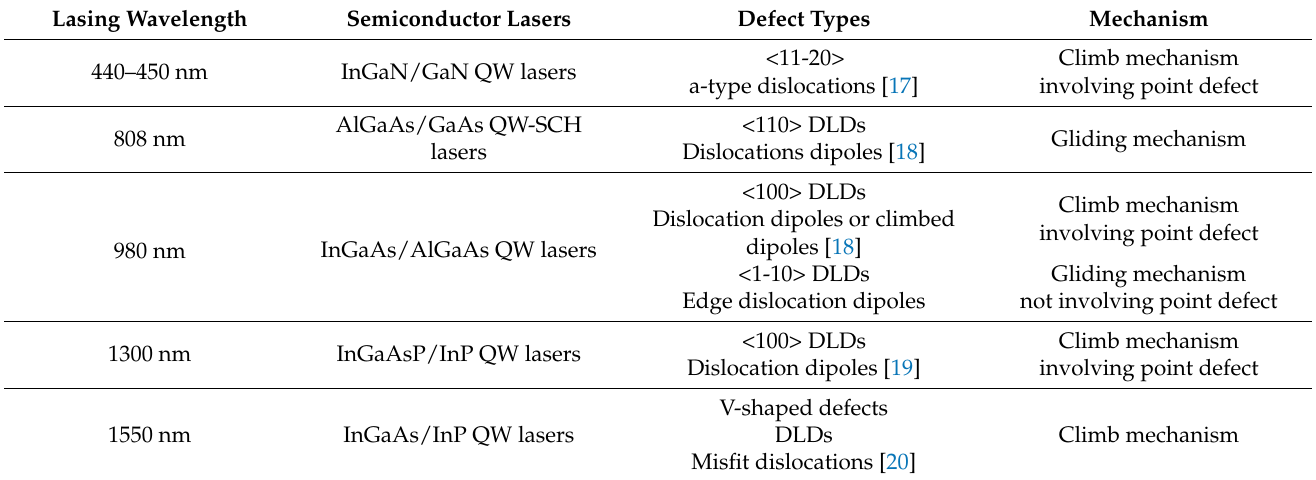
Table 1. Defect types in degraded high-power semiconductor